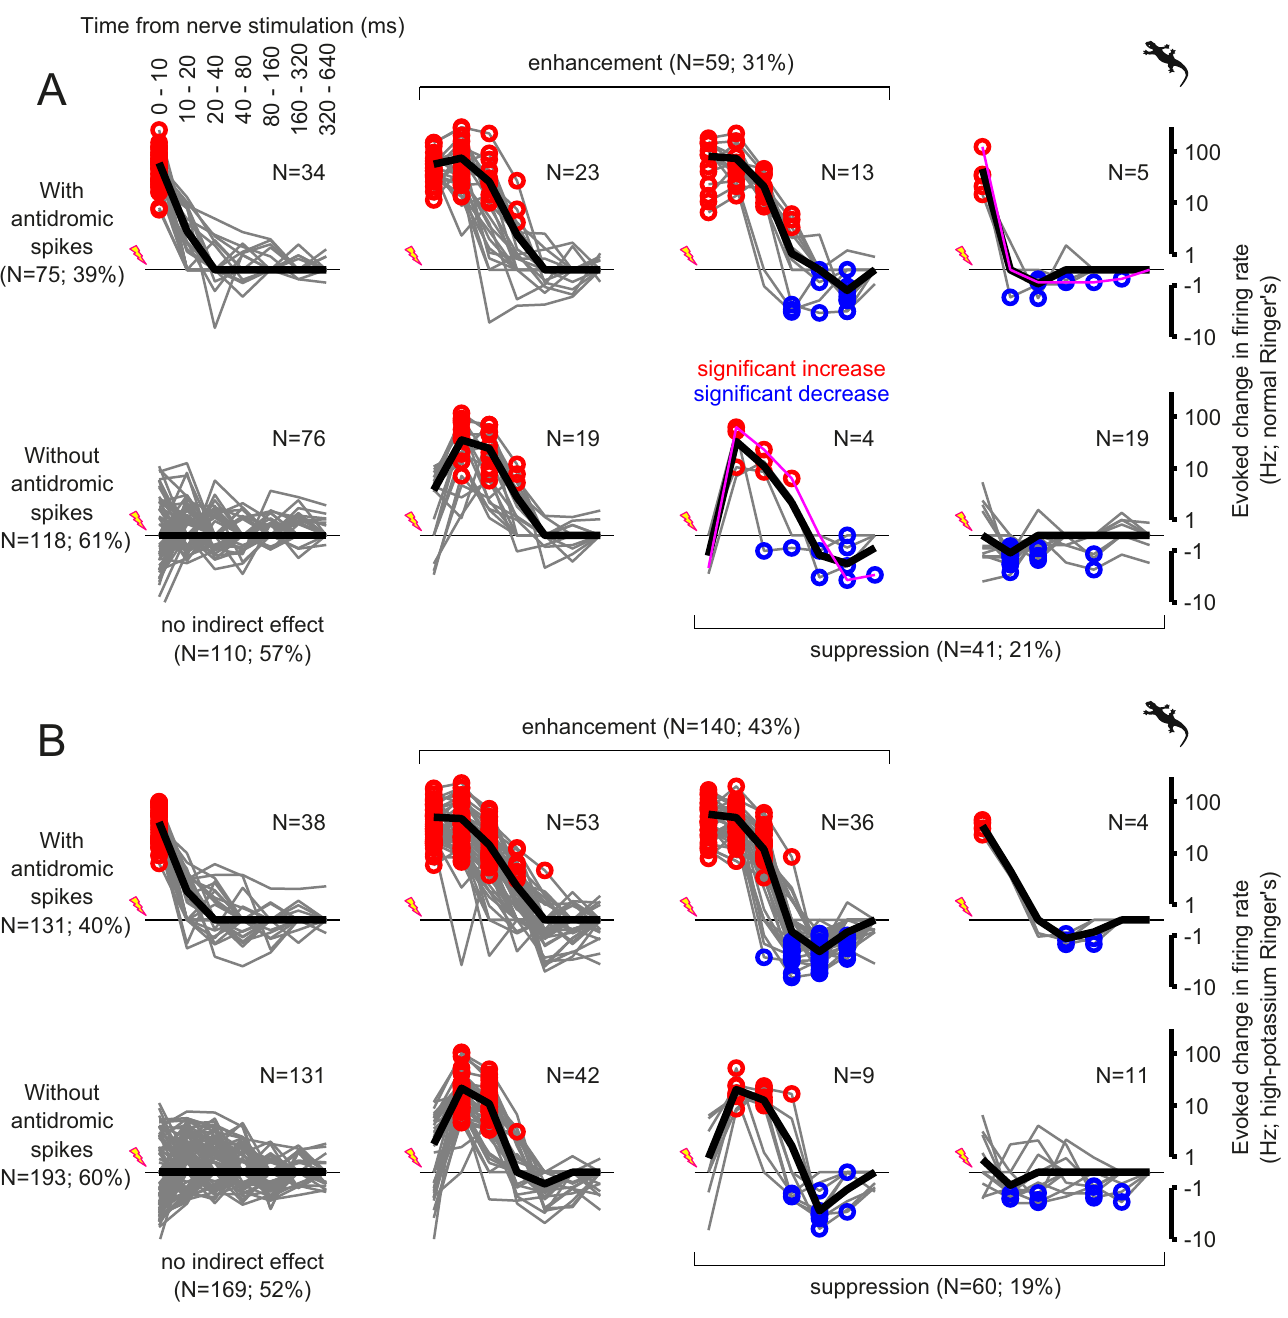
Fig 5. Intrinsic cellular property affects the fast excitation but not slow inhibition after the optic nerve stimulation. Population data of the salamander retinal ganglion cell responses to the optic nerve stimulation in the normal (A) and high-potassium (B; 13 mM KCl) Ringer’s media, in the format of 2-by-4 contingency table. Each gray line represents the evoked change in the firing rate of a cell from its baseline (A, N = 193 in total; B, N = 324; red and blue circles, bins with significant increase and decrease, respectively, with Bonferroni correction), and the black line shows the mean over the cells in each group. In rows, the data were categorized by the presence (top; A, N = 75, B, N = 131; p = 0.5, χ 2 -test) and absence (bottom) of antidromic spikes. In columns, the data were categorized by the outcome of the nerve stimulation: first column, no indirect effect; second and third columns, enhanced firing after the nerve stimulation (A, N = 59; B, N = 140; p = 0.009); third and fourth columns, suppressed firing after the nerve stimulation (A, N = 41; B, N = 60; p = 0.8). The representative responses in Fig 4C and 4D are shown in magenta in A. The cut-off firing rate for the log-PSTH is ± 0.5